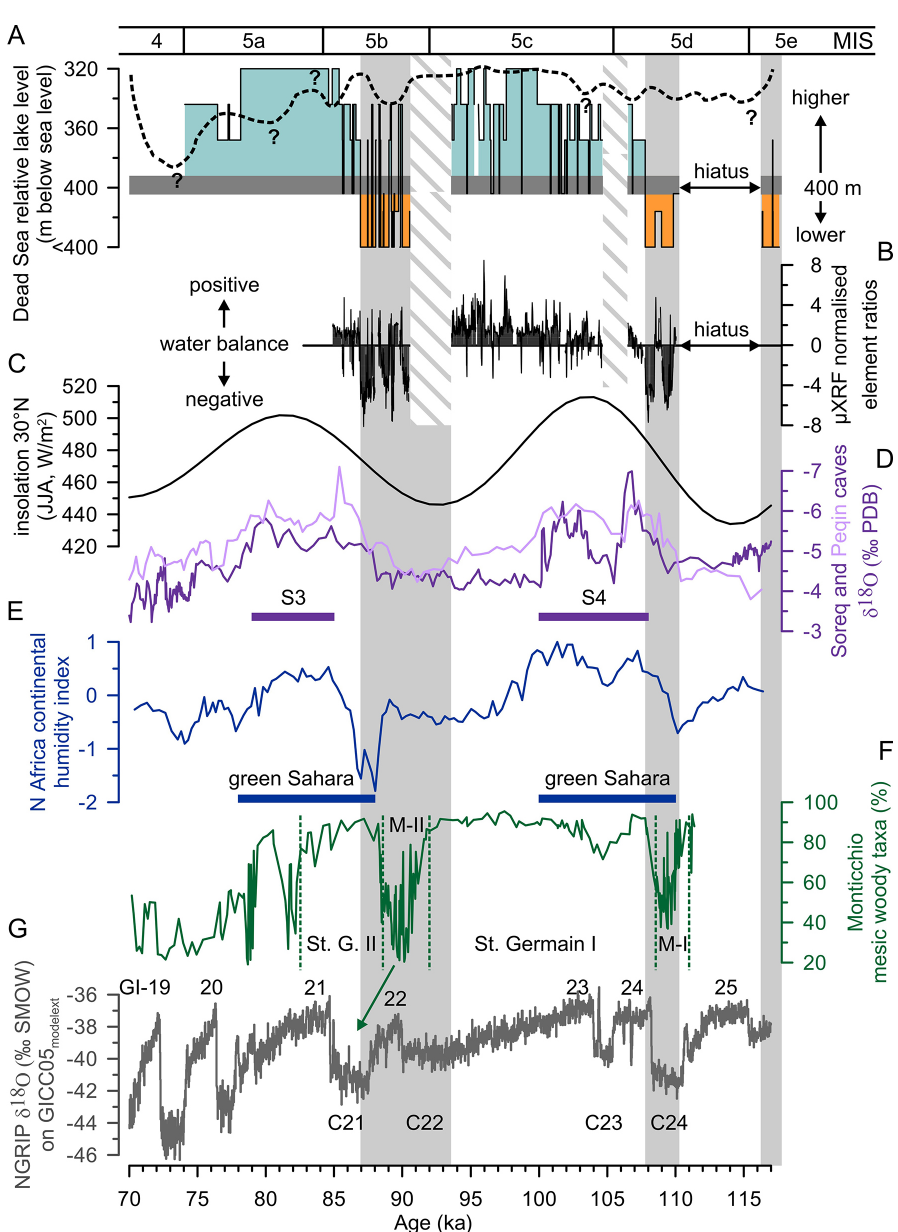
Figure 5. Comparison of the Dead Sea to other records: (a) the relative Dead Sea lake level curve inferred from micro-facies analysis of the deep-basin core 5017-1 (this study; right y axis) and from site PZ-7 from the Perazim Valley (dashed line; left y axis, indicating maximum or minimum relative lake levels; Waldmann et al., 2009); (b) sum of normalised ratios of Ca / (Sr + S) and Ti / Ca as proxies for carbonate and siliciclastic detritus, respectively, and of Sr / Ca, proxy for aragonite, subtracted by the Cl / Br ratio, which is a proxy for halite, [Ca / (Sr + S) + Ti / Ca + Sr / Ca – Cl / Br] indicating the water balance of the lake and agreeing well with the relative lake level curve; (c) mean summer (JJA) insolation at 30 ◦ N (after Laskar et al., 2004); (d) δ 18 O of Soreq and Peqin speleothems, Israel (Bar-Matthews et al., 2003), and eastern Mediterranean sapropel events S3 and S4 (according to Bar-Matthews et al., 2000); (e) humidity index of continental North Africa (core GeoB7920-2) and “green Sahara” phases (Tjallingii et al., 2008); (f) Monticchio (southern Italy) pollen record of mesic woody taxa and Mediterranean pollen zones Melisey (M) I and II, and St. Germain I and II (Brauer et al., 2007; Martin-Puertas et al., 2014) – note a possible chronological shift of 3500 years to the older for 92–76ka according to Martin-Puertas et al. (2014); (g) Greenland ice core δ 18 O record on GICC05 modelext timescale (Wolff et al., 2010) – also indicated are Greenland interstadials (GI) after Rasmussen et al. (2014) and North Atlantic ice-rafting events C21 to C24 (Chapman and Shackleton, 1999). Marine isotope stages are given according to Wright (2000). Grey vertical bars indicate periods of negative water balance in the Dead Sea; obliquely banded bars: no core